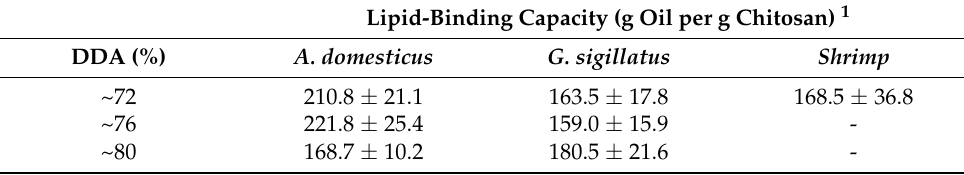
Table 3. Cricket and shrimp chitosan lipid-binding